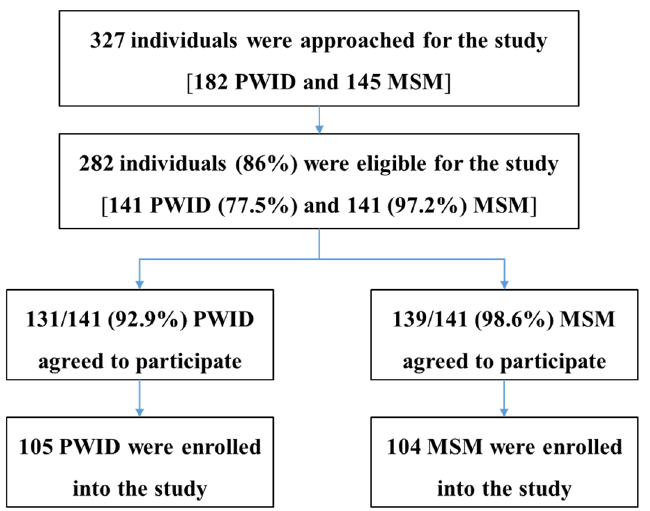
Figure 1. Flowchart of eligible individuals who were enrolled in the study (PWID: people who inject drugs and MSM: men who have sex with men).